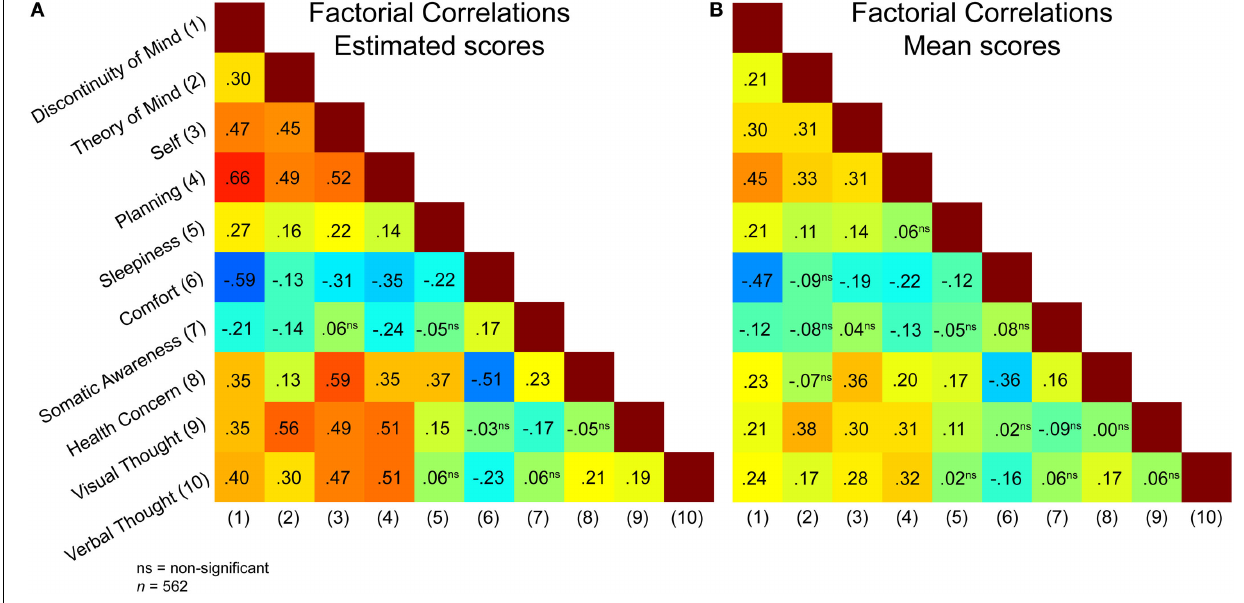
the factors based on mean scores alone (B) , supporting the choice for the simplified mean-score approach to quantifying mind